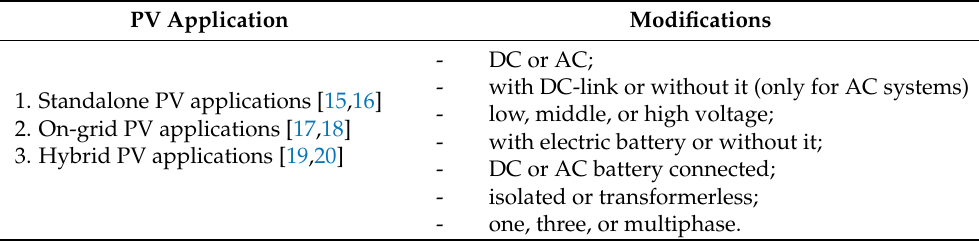
Table 1. Common PV application descriptions and